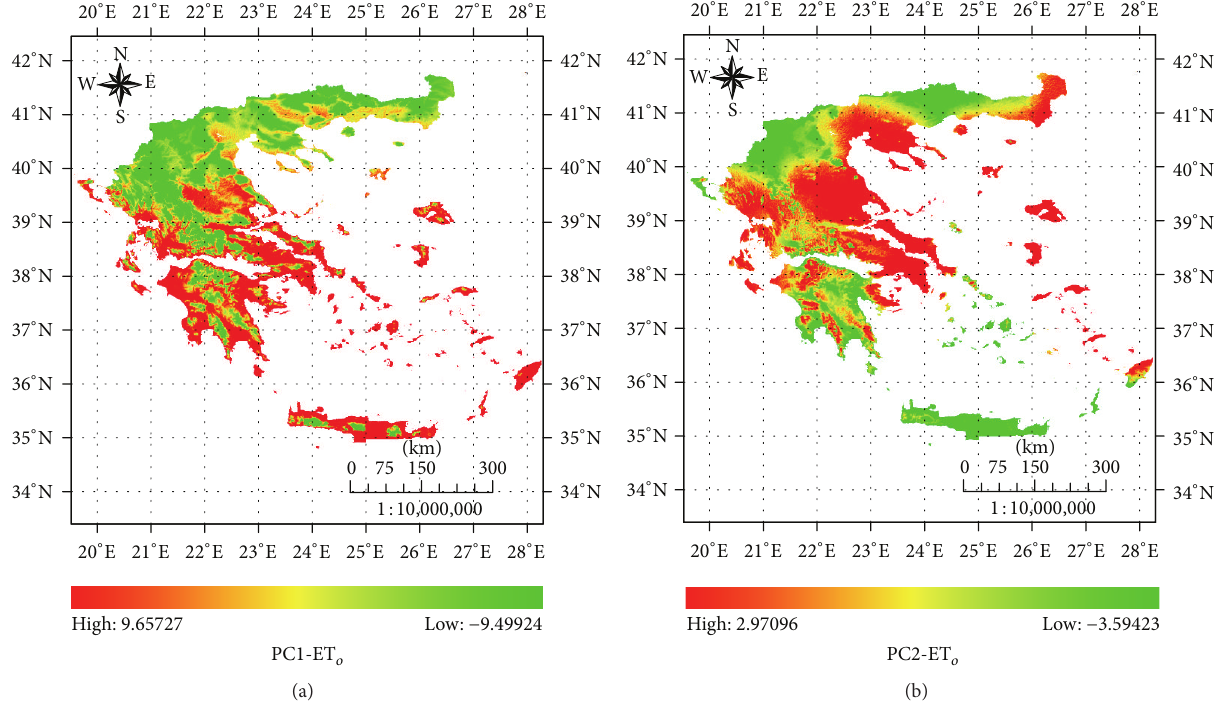
Figure 3: The first two principal components PC-1 and PC-2 that account for the 97.9% of the ET 𝑜 variance.